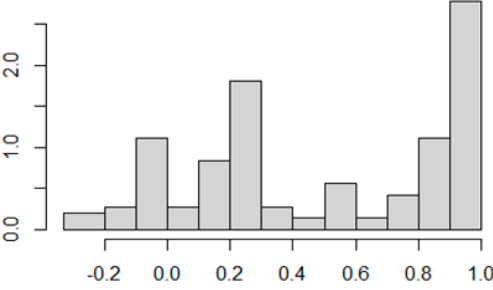
Figure 7. The histogram for rank correlation—2020 based on a statistical computing platform [32].